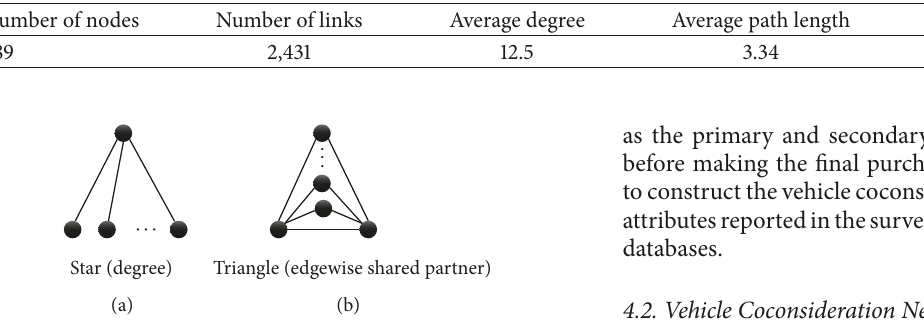
Table 2: Representative network characteristics of the generated coconsideration network.